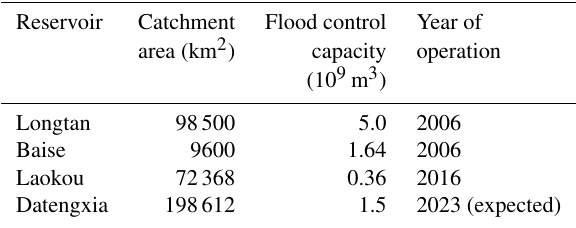
Table 1. Reservoir information for the Xijiang River